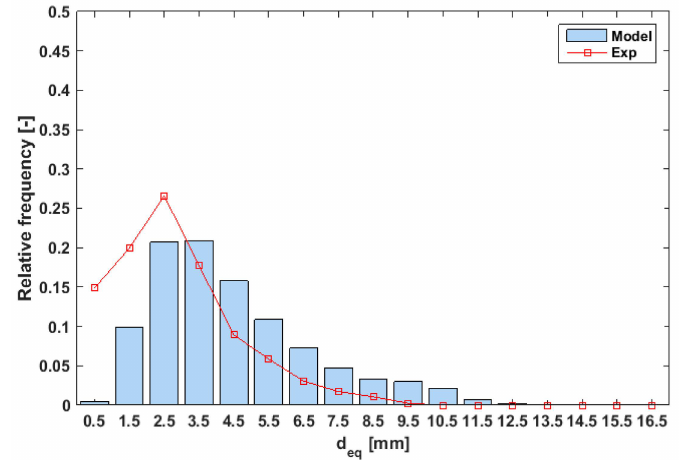
Figure 14. Comparison between PBM results and experimental data: Martinez constant and uniform BSD at the inlet: U G = 0.0074 m/s.